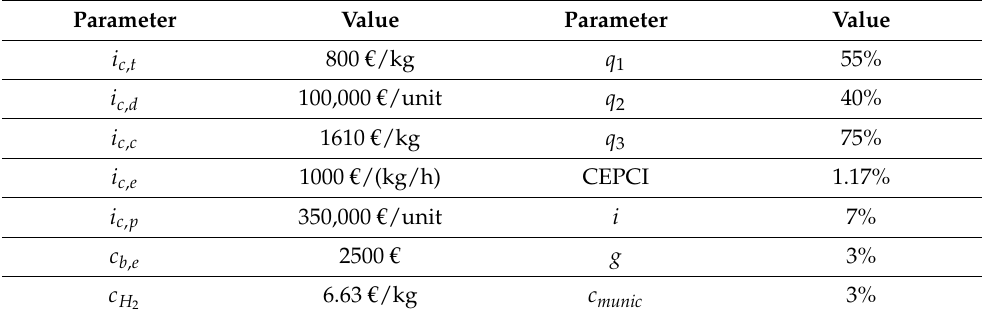
Table 1. Economic